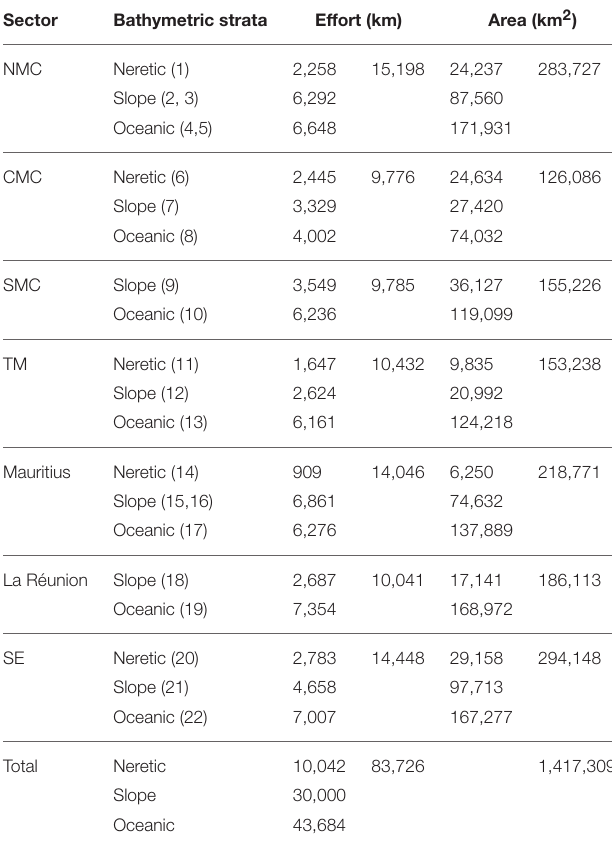
TABLE 1 | Area of surveyed blocks and bathymetric strata, with corresponding effort selected for analysis. Sector